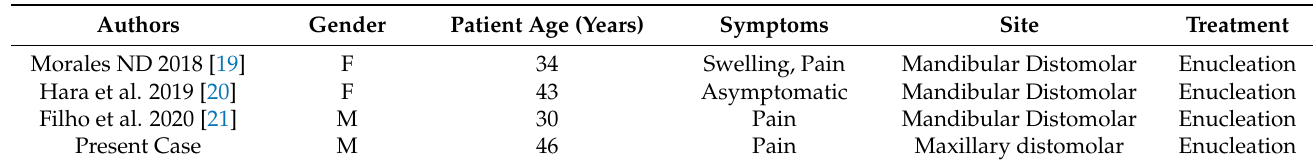
Table 1. Supernumerary distomolar associated with a dentigerous cyst (cases described in the